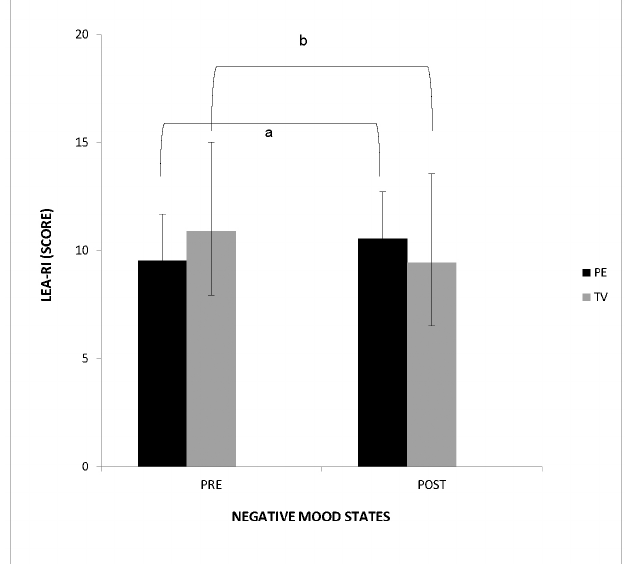
Figure 3. Mean and standard deviation of pre- and post-scores of negative mood states assessed using the Abbreviated and Illustrated Mood States Inventory (LEA-RI) between physical exercise (PE) and TV viewing conditions in older active women (n = 54, Rio Claro - SP, 2015, 2016). a,b paired sample t -test ( P <